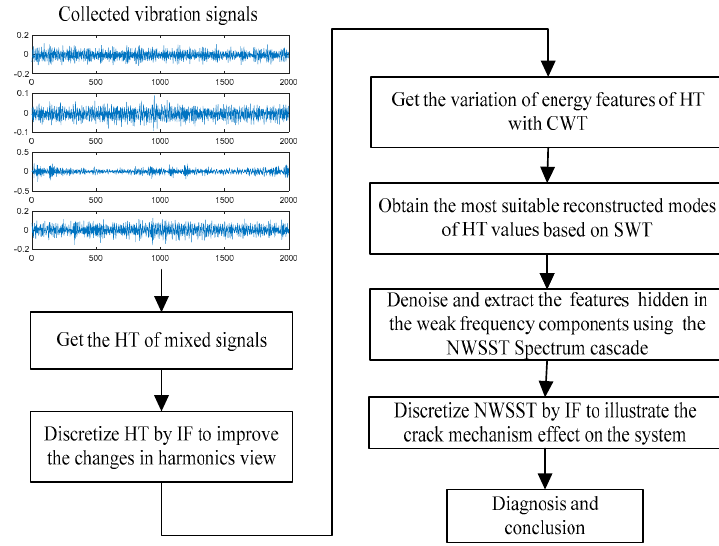
Figure 4. Flowchart of the proposed method.